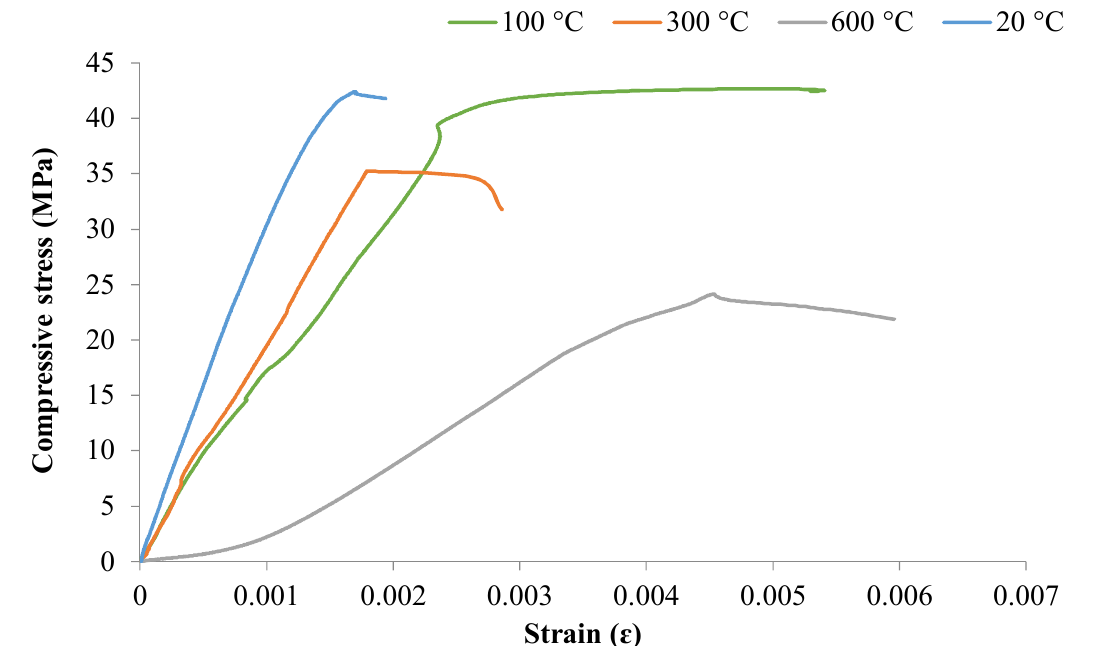
Figure 11. Compressive stress–strain curves for M4 after 28 days at high temperatures.